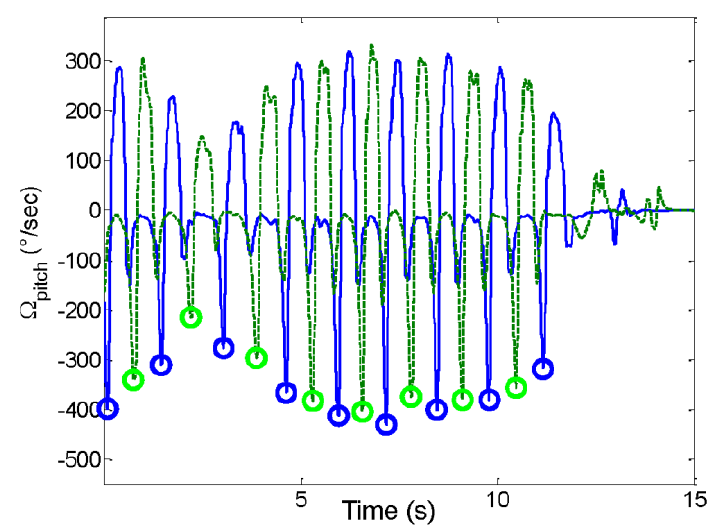
Figure 4. Zoom-in on the walking period from Figure 3. The pitch angular velocity of the right foot is shown as a continuous line, and the left foot as a dashed line. TO instants are represented by circles.